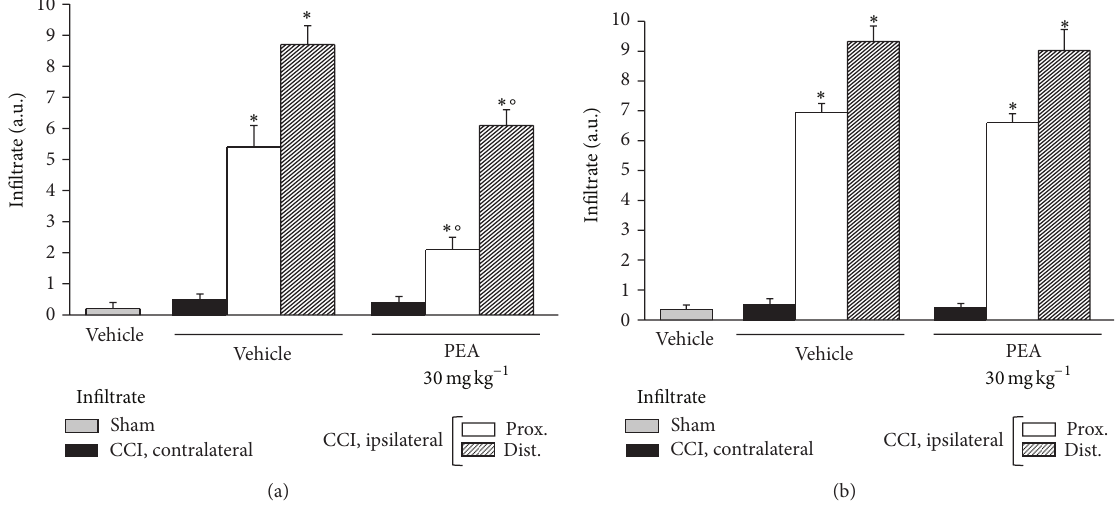
Figure 5: Infiltrate evaluation. On the 14th day after CCI, 5 𝜇 m nerve sections of formalin-fixed tissues were analyzed by Azan-Mallory stain, and the presence of inflammatory infiltrate was evaluated and quantified by an arbitrary scale starting from 1, mild infiltrate, up to 10, severe infiltrate. Effect of PEA repeated treatments (30 mgkg −1 s.c. daily) was observed in (a) PPAR- 𝛼 +/+ and in (b) −/− mice where the distal and the proximal tract of the ipsilateral ligated nerve of CCI was compared with the contralateral and with the sciatic nerve of sham-operated animals. Quantitative analysis was performed evaluating 5 animals for each group. ∗ 𝑃 < 0.05 was considered as significantly different from sham, vehicle-treated mice. ∘ 𝑃 < 0.05 was considered as significantly different from CCI, vehicle-treated mice.